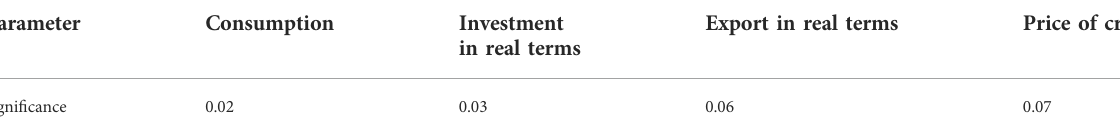
TABLE 1 Impact of factors on GDP.